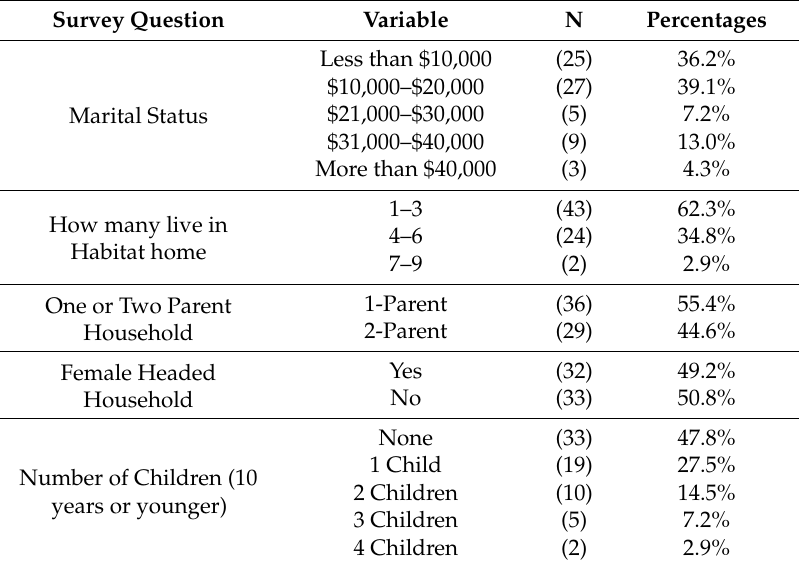
Table 4. Profile of Houston Habitat